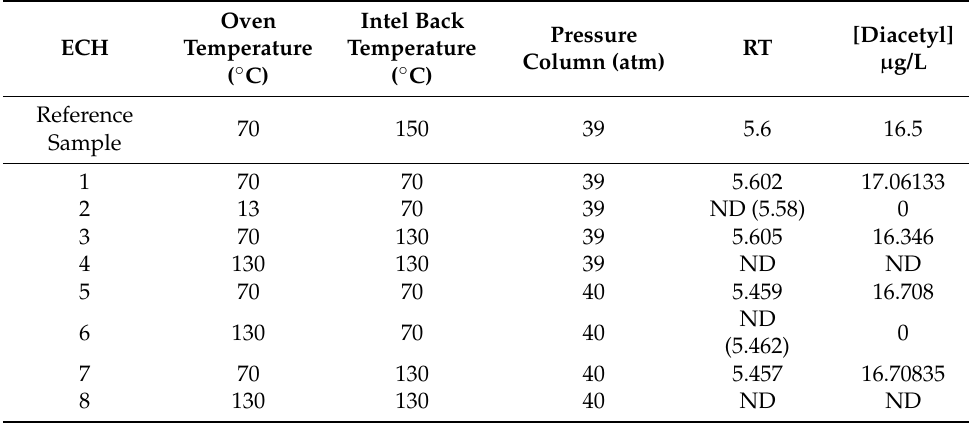
Table 4. The results obtained (response) after the application of the experimental